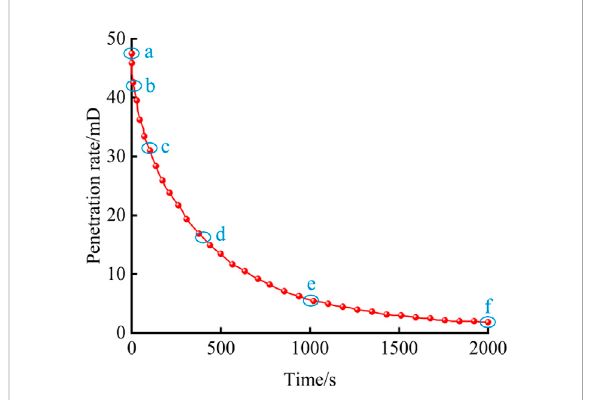
FIGURE 12 Permeability of grouting coal sample with time.